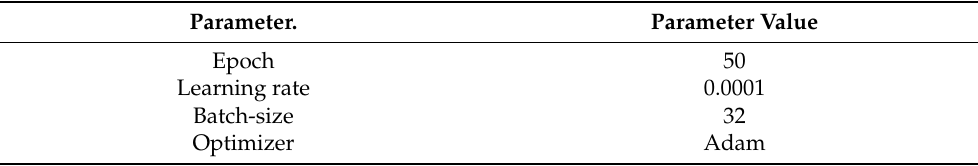
Table 3. Parameters for model